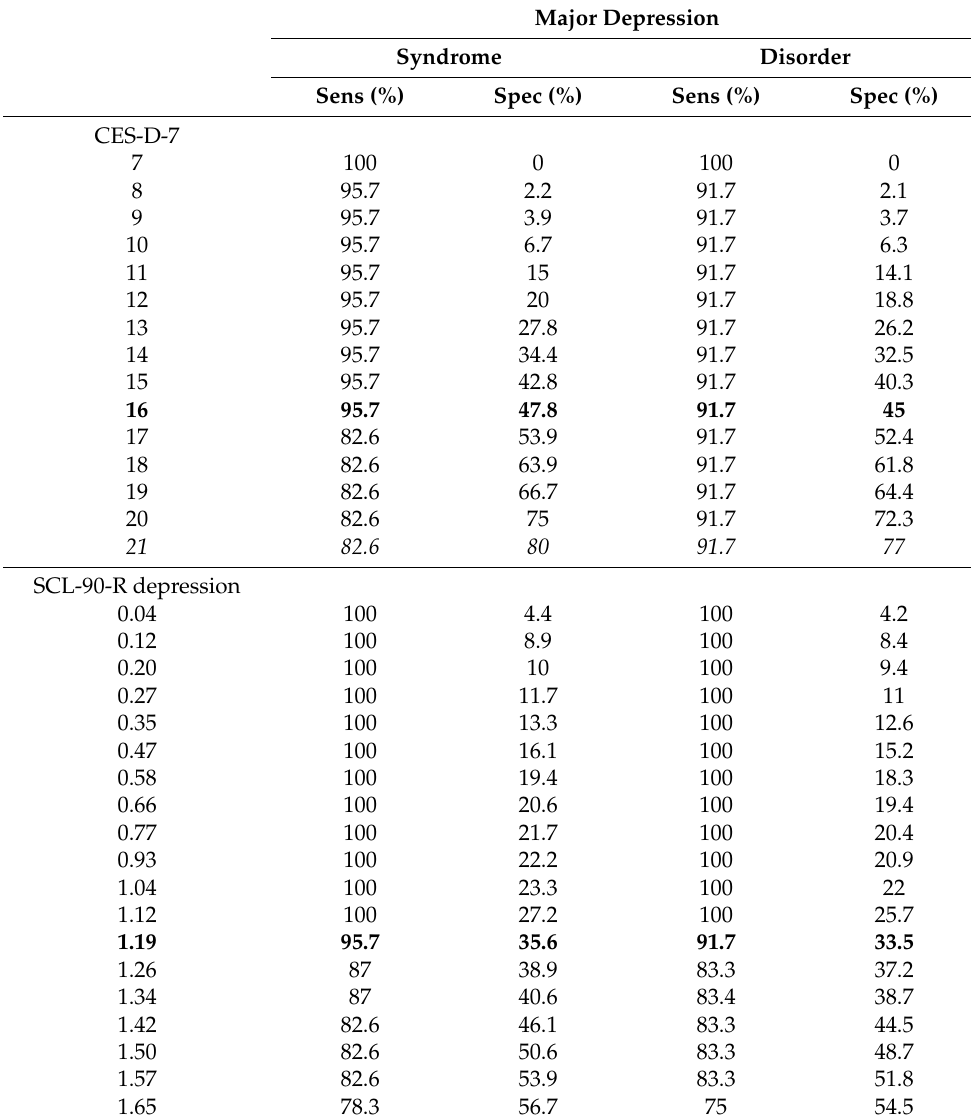
Table 2. Comparison of possible cut-off scores of CES-D-7 and SCL-90-R’s depression